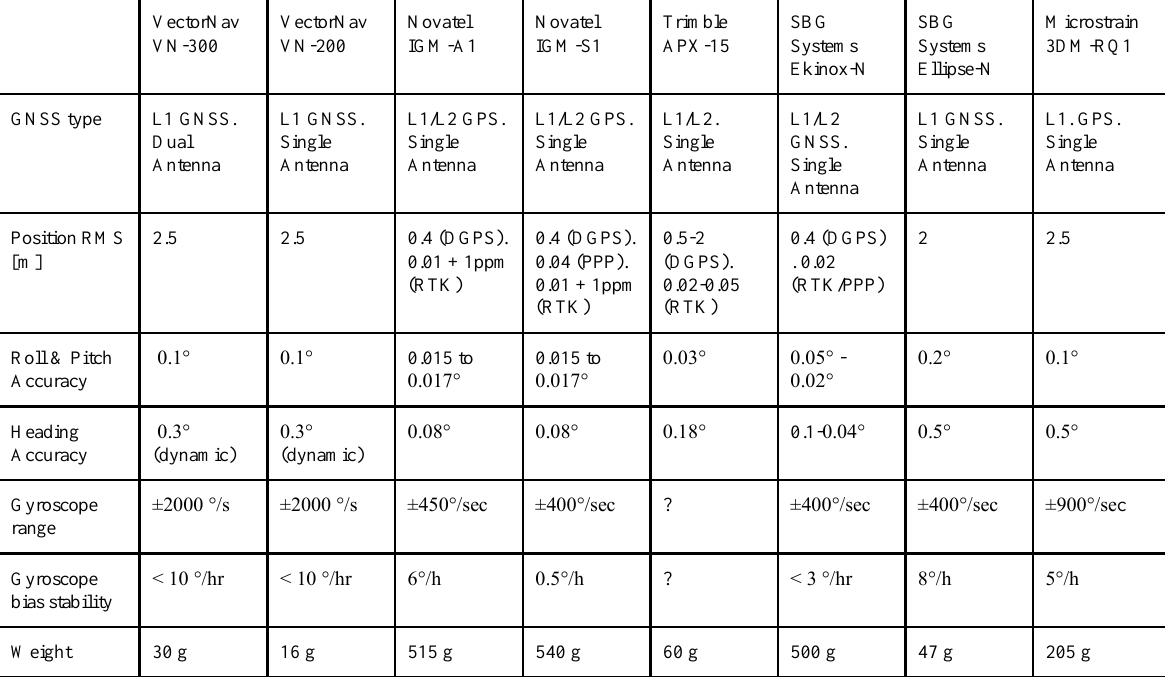
Table 3. Light UAV GNSS/IMU modules